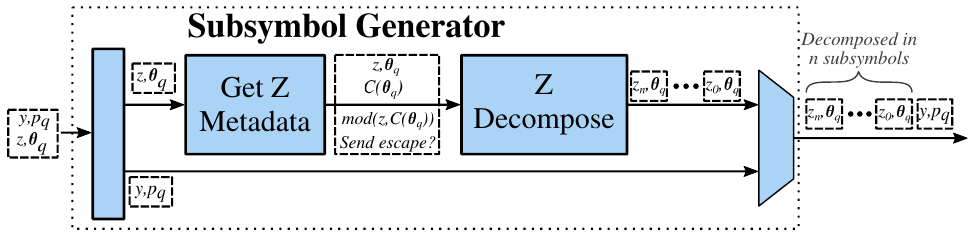
Figure 7. Subsymbol Generator block diagram and data transformations within